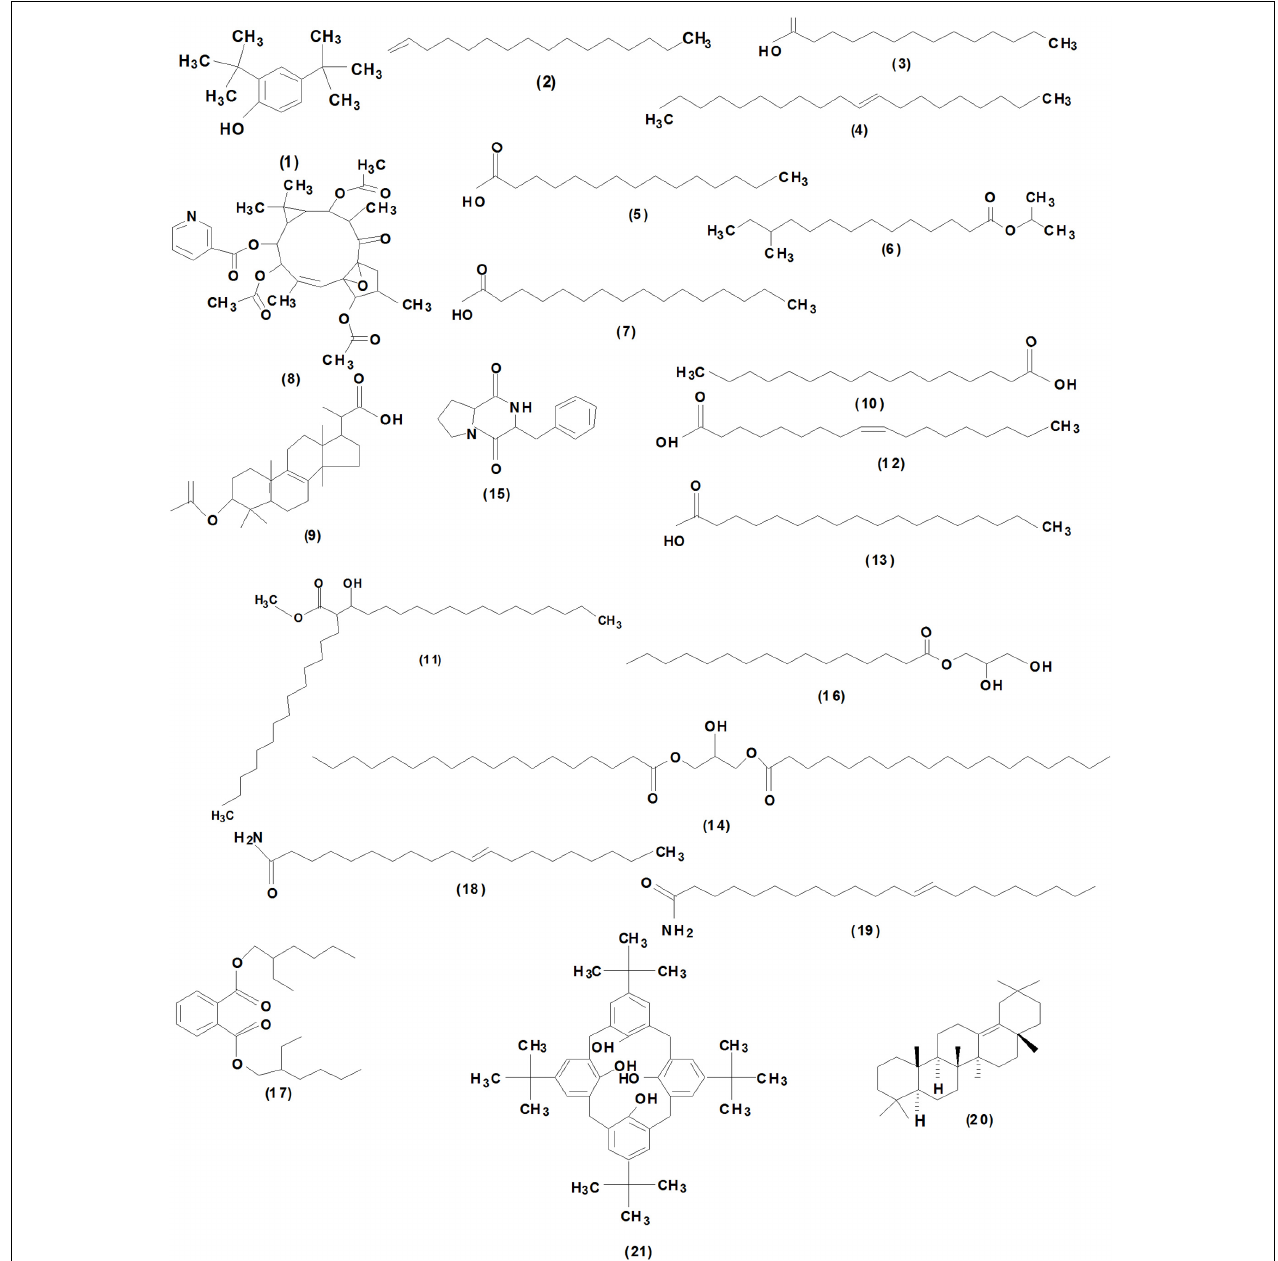
FIGURE 6 | Chemical structures of the identified compounds from crude extracts of Streptomyces sp.